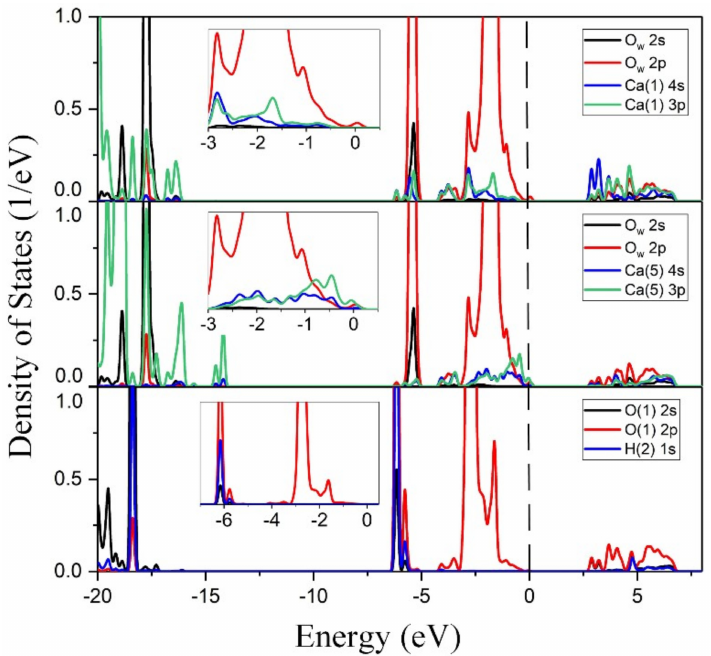
Figure 7. Partial density of states for participating atoms in freshly formed bonds from